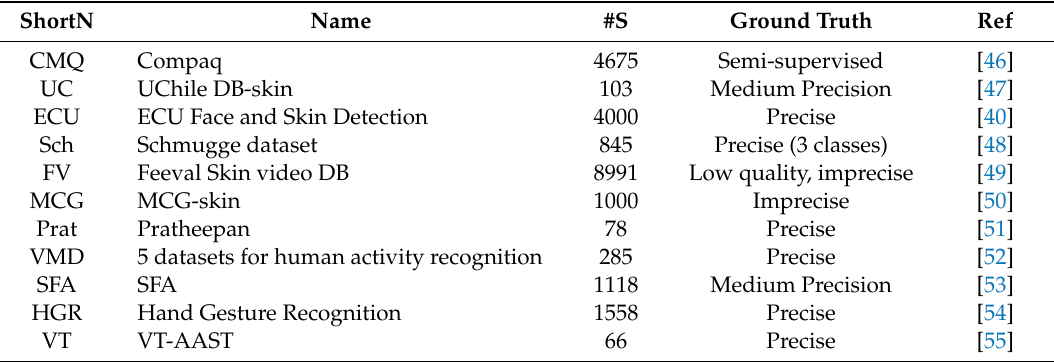
Table 4. Summary of the Skin detection datasets with ground truth used for image segmentation: